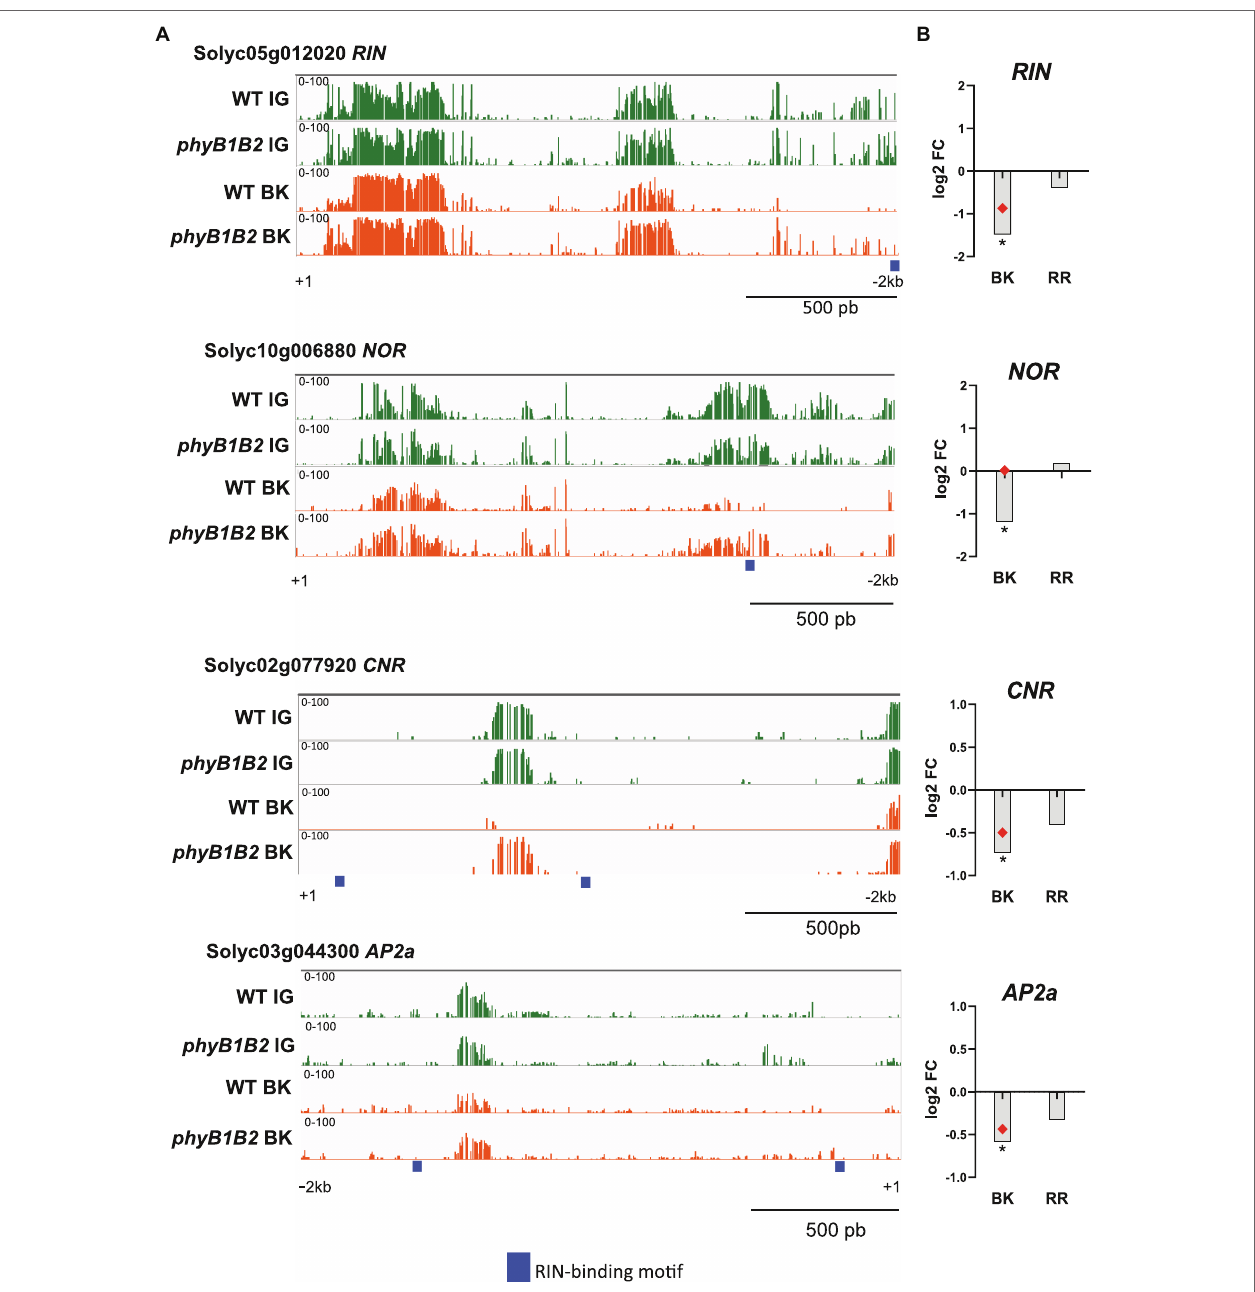
FIGURE 4 | PHYB1/B2 influence on fruit ripening is associated to the promoter demethylation of master ripening-associated transcription factors. (A) Differentially methylated promoters of the RIPENING INHIBITOR ( RIN ), NON-RIPENING ( NOR ), COLORLESS NON-RIPENING ( CNR ) and APETALA 2a ( AP2a ) loci between the phyB1B2 and WT genotypes. Green and orange indicate cytosine methylation levels in immature green (IG) and breaker (BK) fruits, respectively. Thick blue lines indicate RIN peak binding sites according to ChIP-seq data (Zhong et al., 2013). (B) Relative expression from the RT-qPCR assay of genes encoding master ripening transcription factors in BK and red ripe (RR) fruits from phyB1B2 . Expression levels represent the mean of at least three biological replicates and are relative to WT. Asterisks indicate statistically significant differences by two-tailed Student’s t -test compared to WT (* p < 0.05). Red dots indicate data from RNA-seq in the same fruit developmental stage validated by